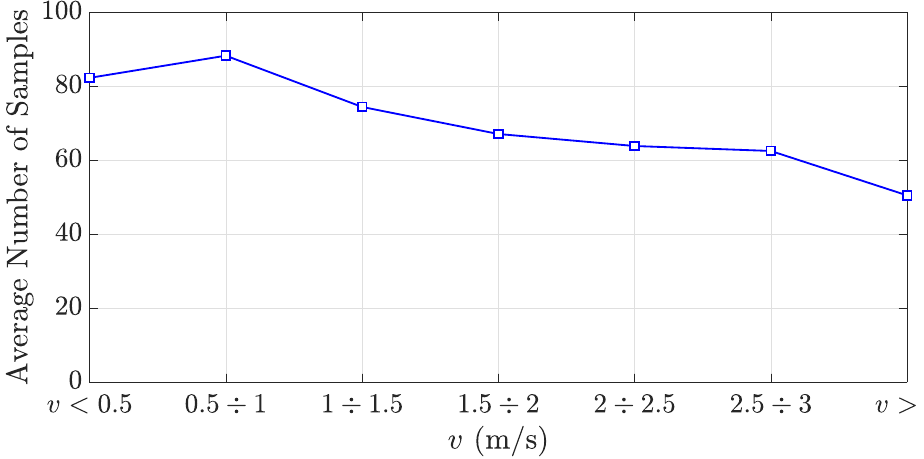
Figure 14. Average number of samples vs. forklift speed v